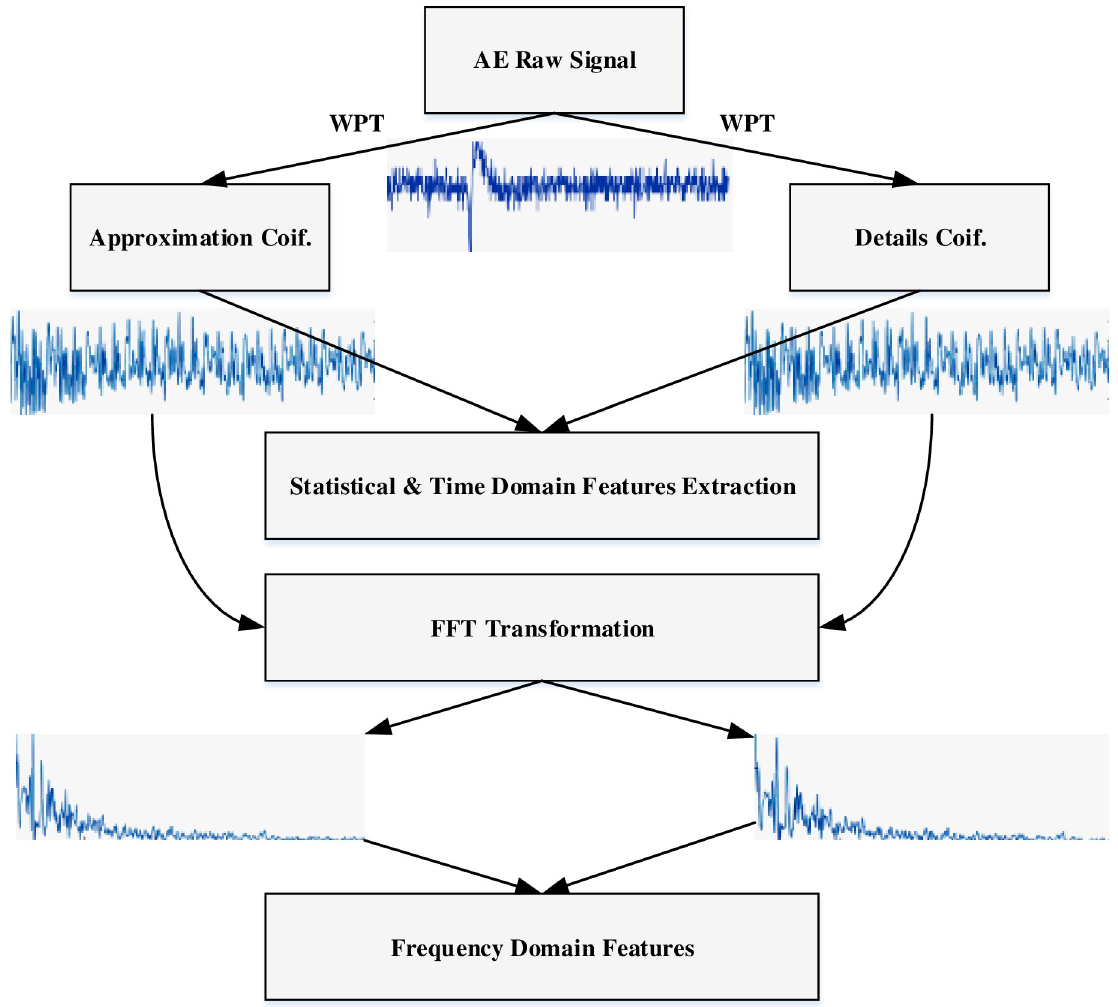
Fig 10. Feature extraction process of AE datasets for machine learning